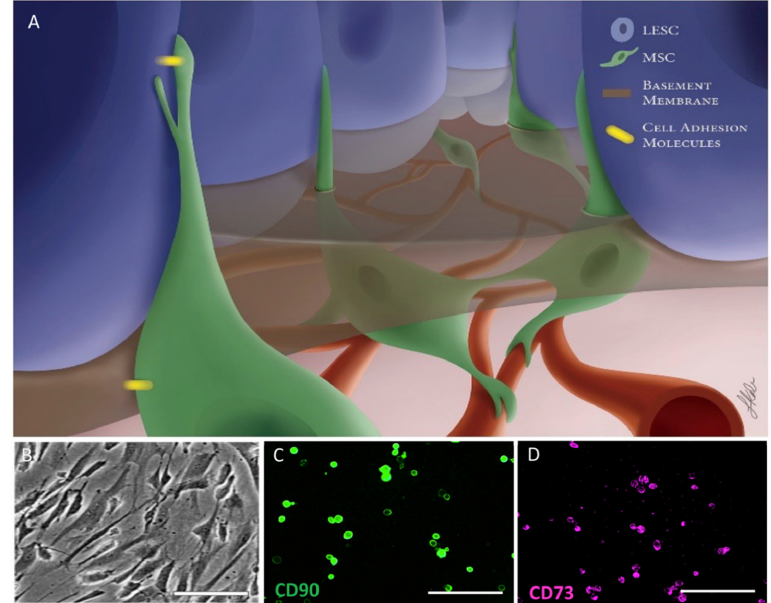
Figure 2. Limbal stem cell interactions. ( A ) Illustration demonstrating the interaction between limbal MSCs and LESCs. Use of illustration permitted by [5]. ( B ) Representative picture of human Limbus MSCs using brightfield microscopy. ( C , D ) Human limbus mesenchymal stromal cell in suspension expressing markers CD 90 and